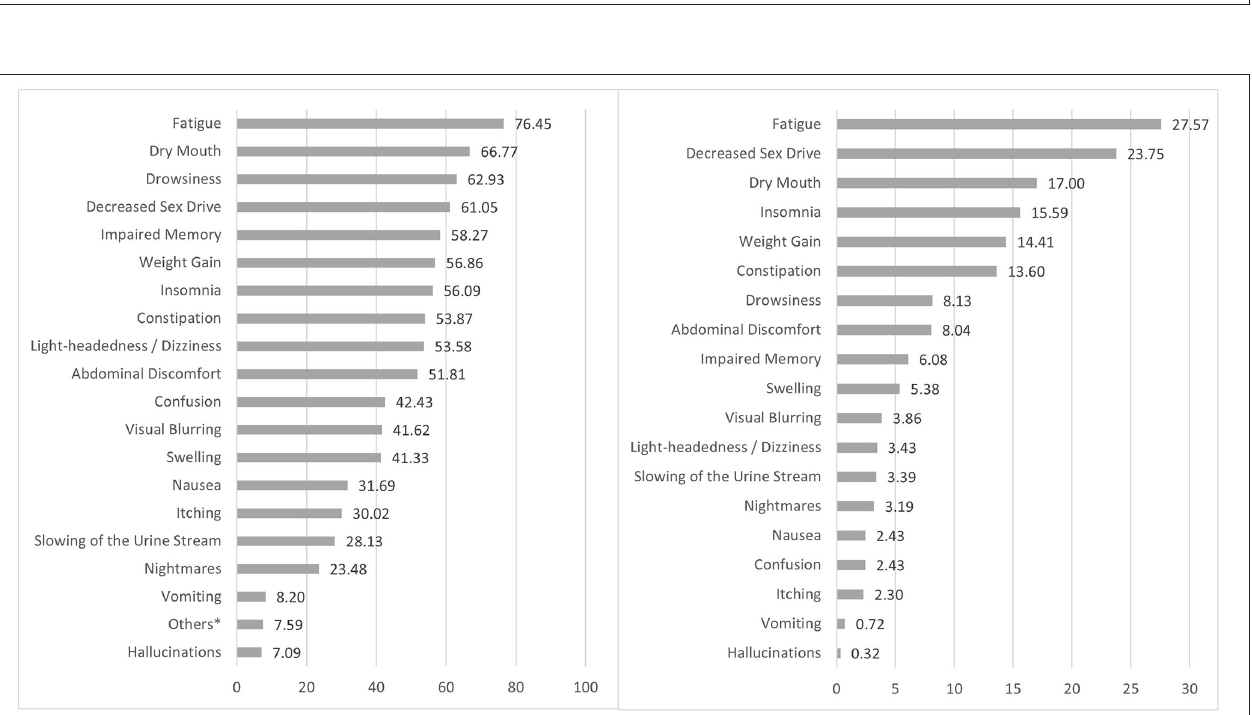
FIGURE 1 | Distribution (%) of gender role subgroups in women (left) and men (right). Feminine: described themselves as tender and sensitive to others. Masculine: described themselves as athletic, having leadership, and being self-confident. Androgynous: scored high on all these traits. Undifferentiated: scored low on all these traits.